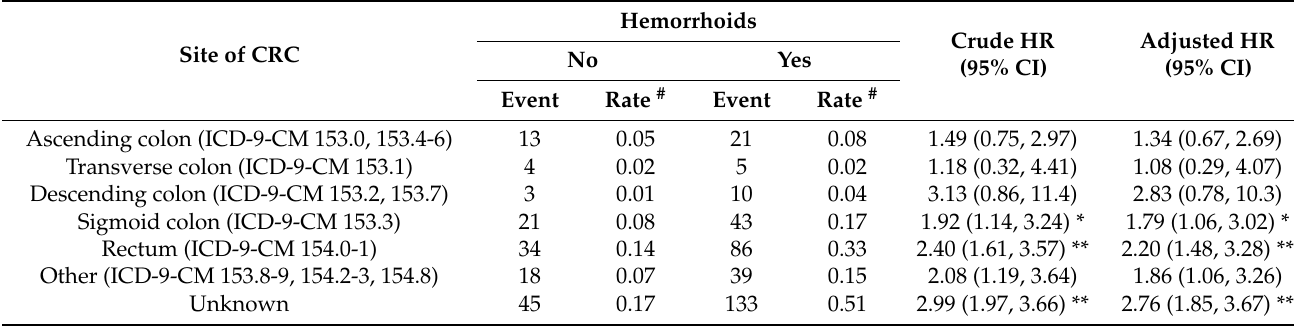
Table 3. Incidences and hazard ratio of colorectal cancer estimated by colorectum site compared between cohorts with and without